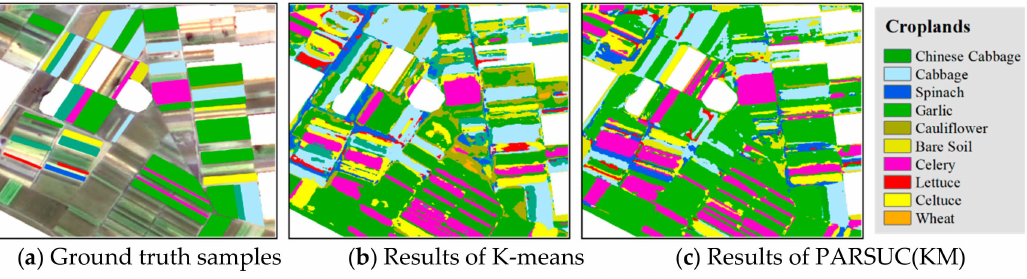
Figure 10. Ground truth samples, classification results of PARSUC(KM) and K-means at region